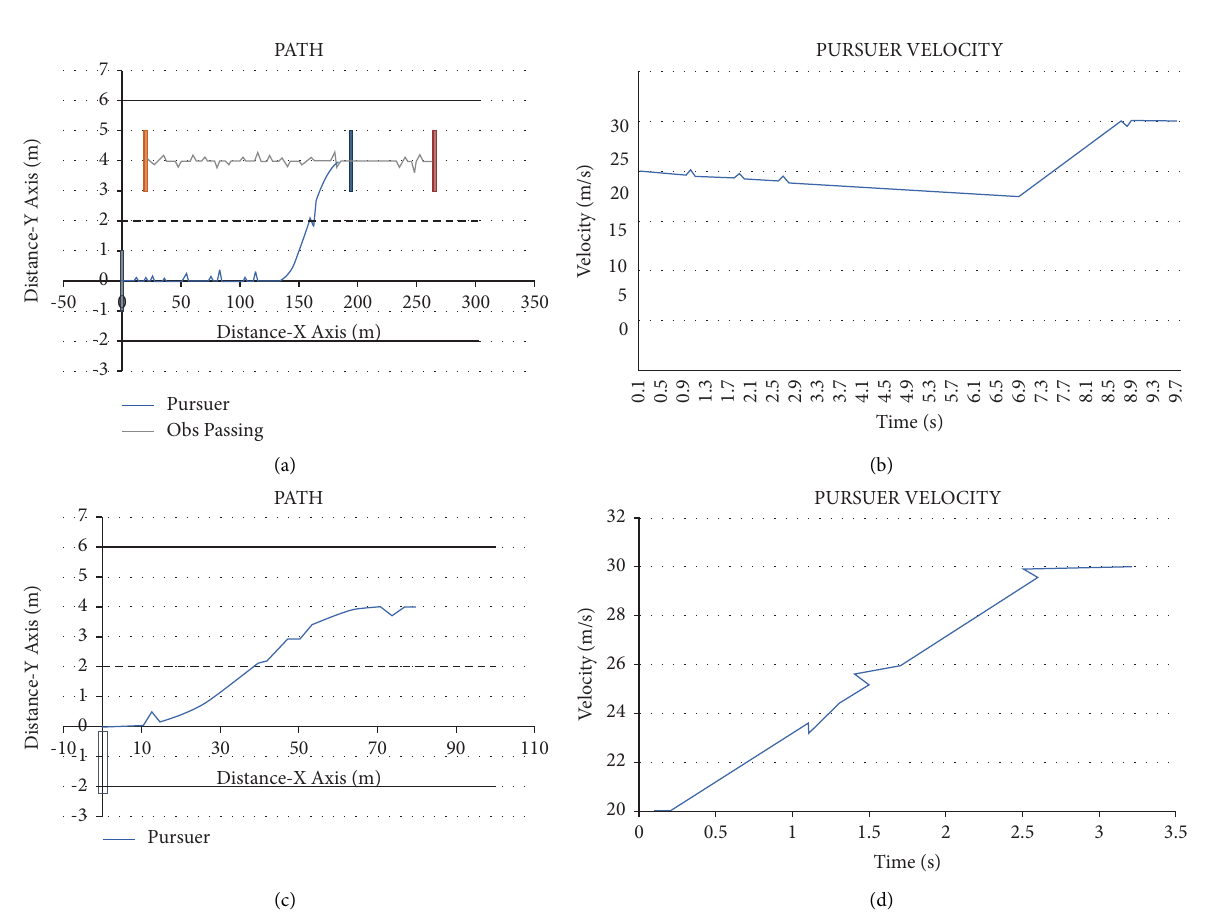
Figure 13: (a) Path of P . (b) Velocity plot of P . (c) Path of P . (d) Velocity plot of P .